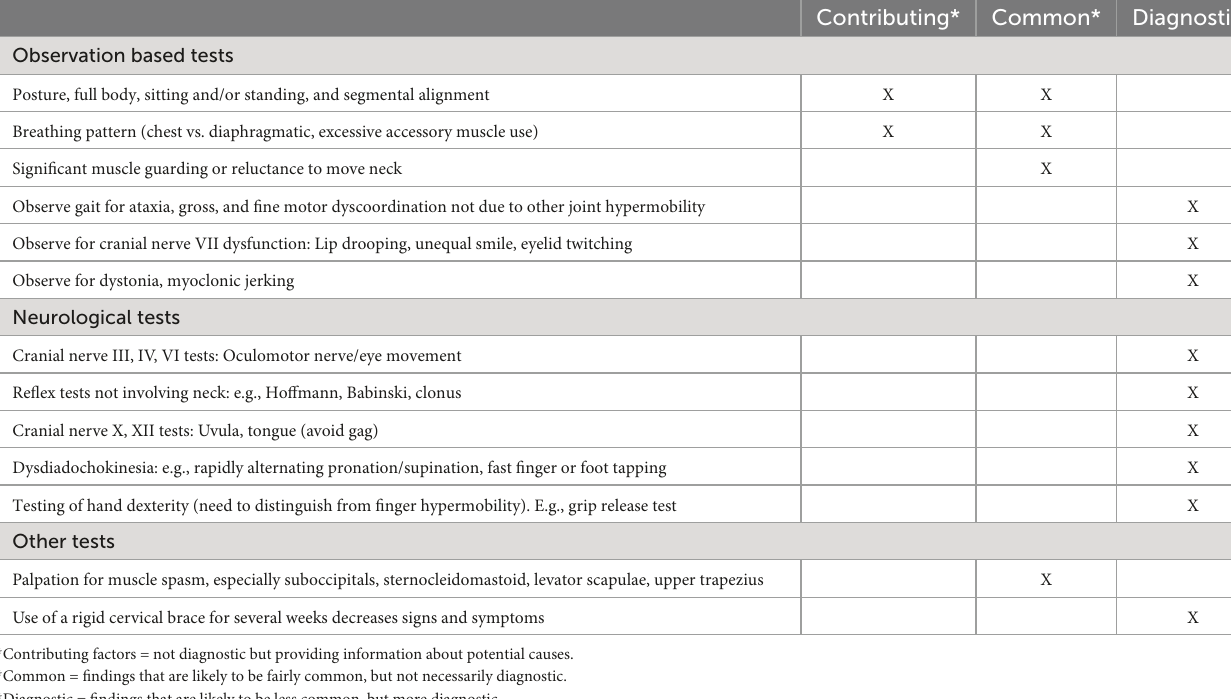
TABLE 8 Physical tests and findings for moderate and low irritability patients only.